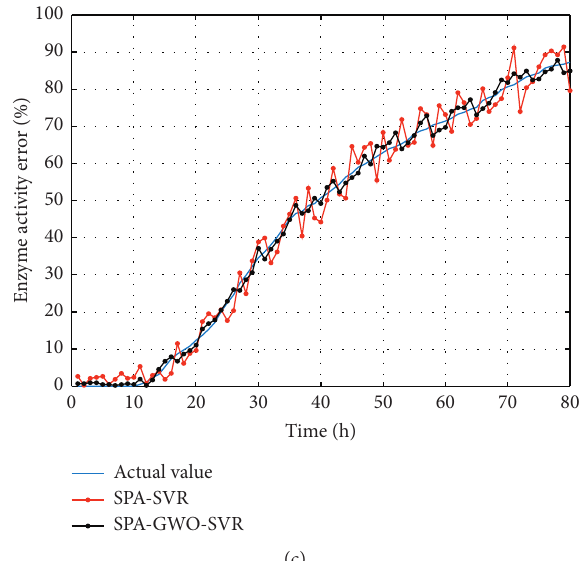
Figure 5: Comparisons of the predicted result with the reference of actual value for the process of marine protease fermentation. (a) Prediction results of cell concentration. (b) Prediction results of matrix concentration. (c) Prediction results of enzyme